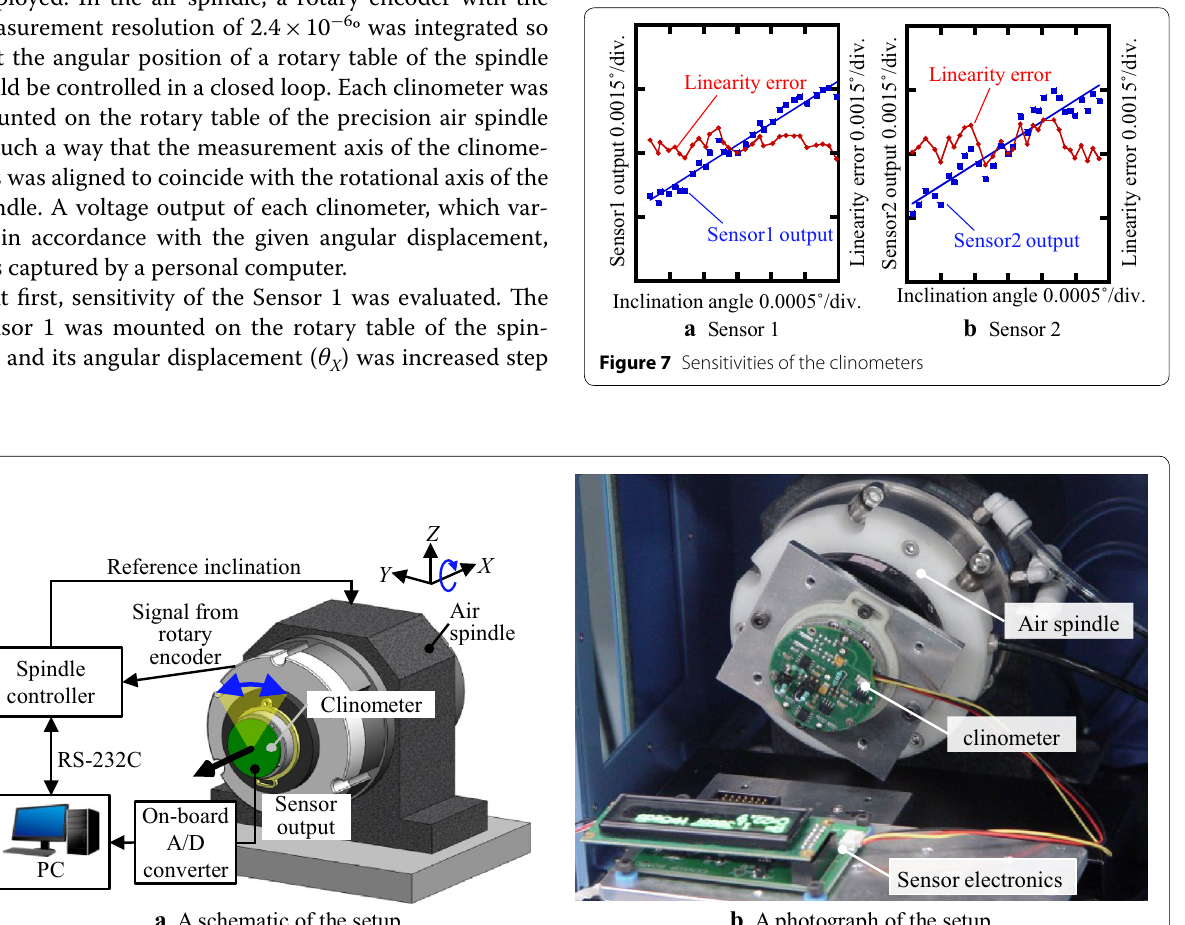
Figure 6 Calibration system for the clinometers